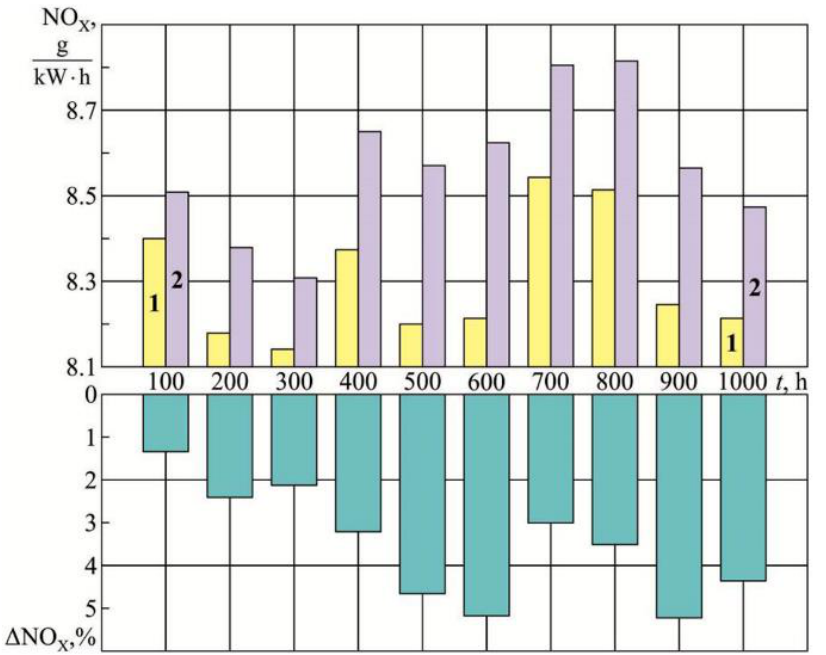
Figure 12. Change in NOX concentrations in exhaust gases for the diesel 5L23/30 MAN-B&W Diesel Group under different experimental conditions: 1 — diesel AE 1; 2 — diesel AE 2.